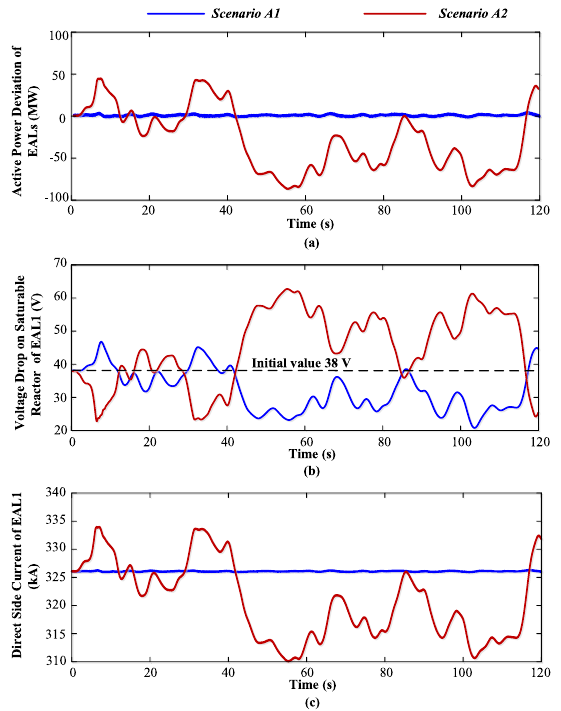
Fig. 11 a The active power deviation of EALs (cid:31) P EAL in Scenario A1 and Scenario A2 , b The voltage drop on saturable reactor of EAL1 (cid:31) U SR 1 in Scenario A1 and Scenario A2